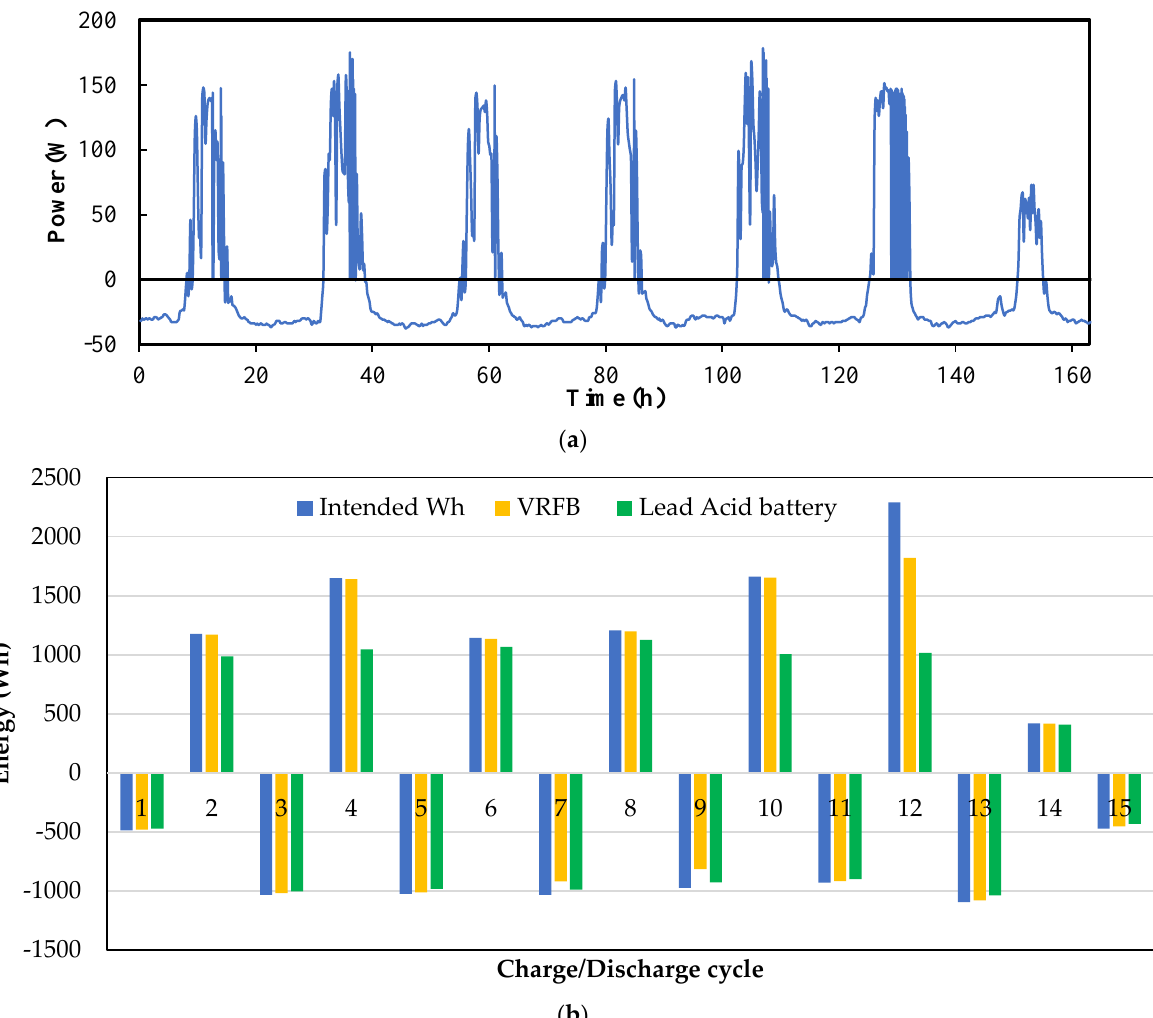
Figure 8. ( a ) Lead acid battery performance for S P = 1 / 8 and S T = 1. ( b ) Energy comparison for VRFB with 40 L with S P = ½ and S T = ½ with 2 lead acid battery performance.